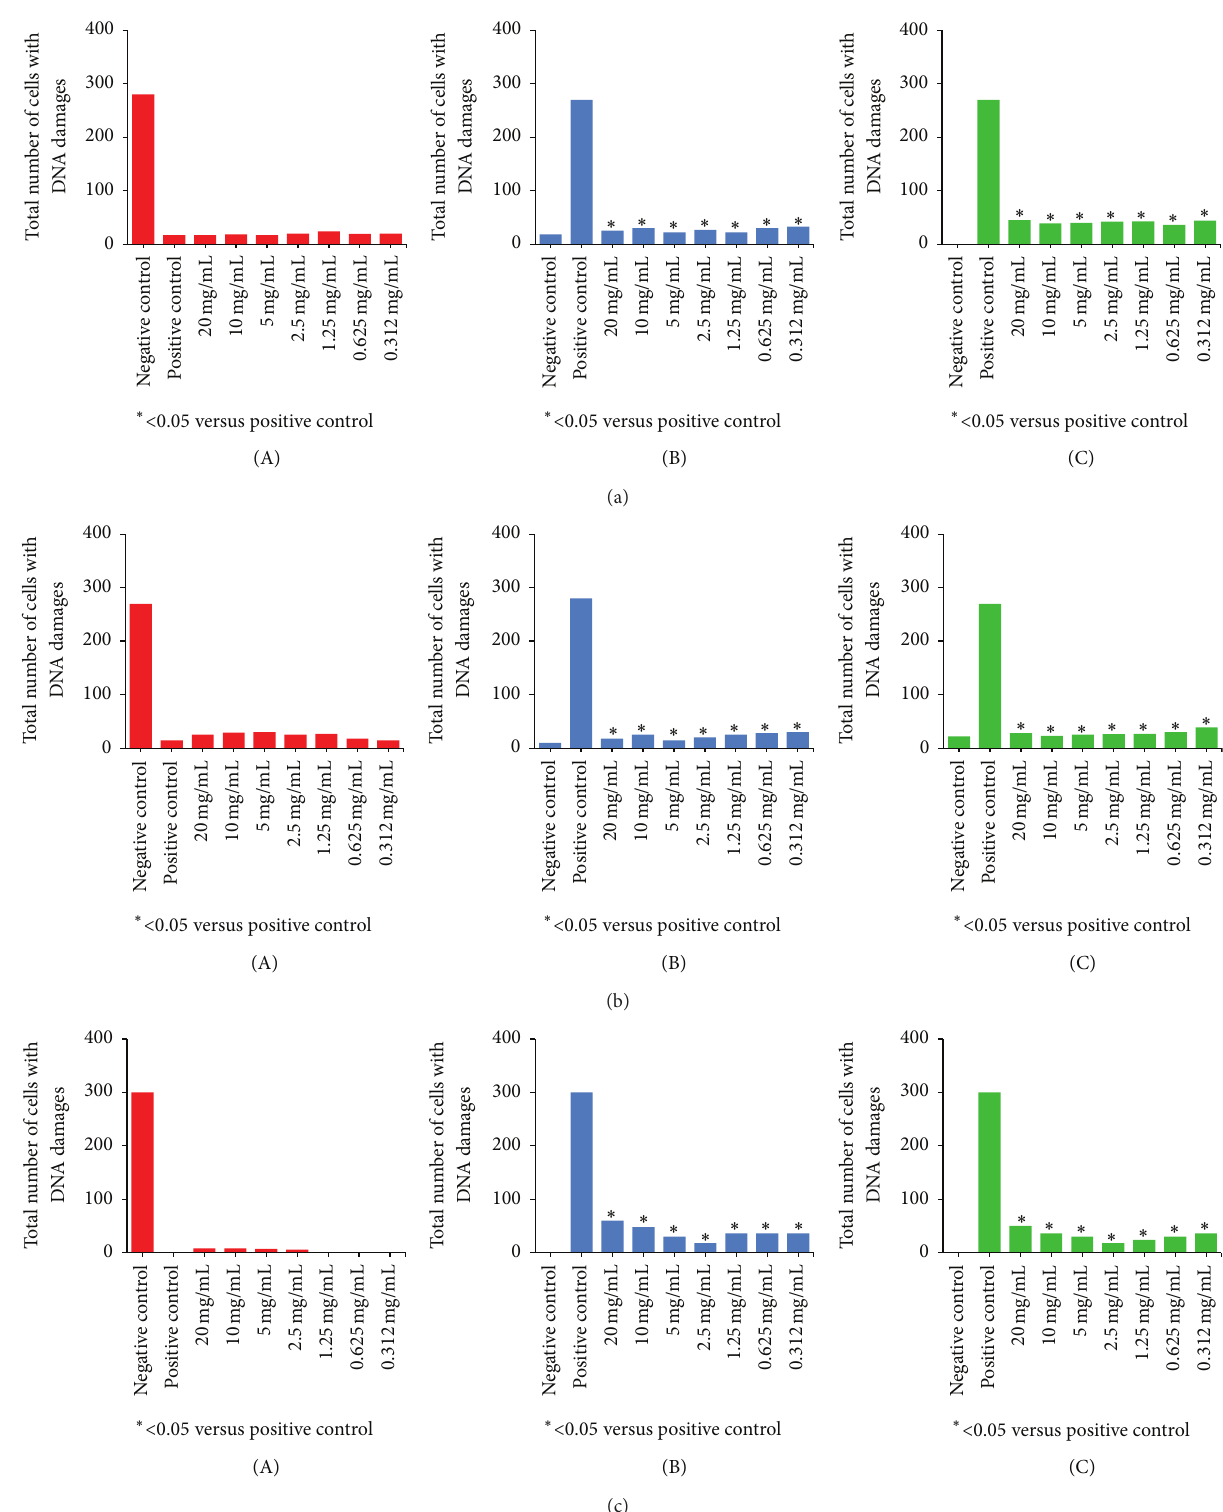
∗ < 0.05 versus positive control